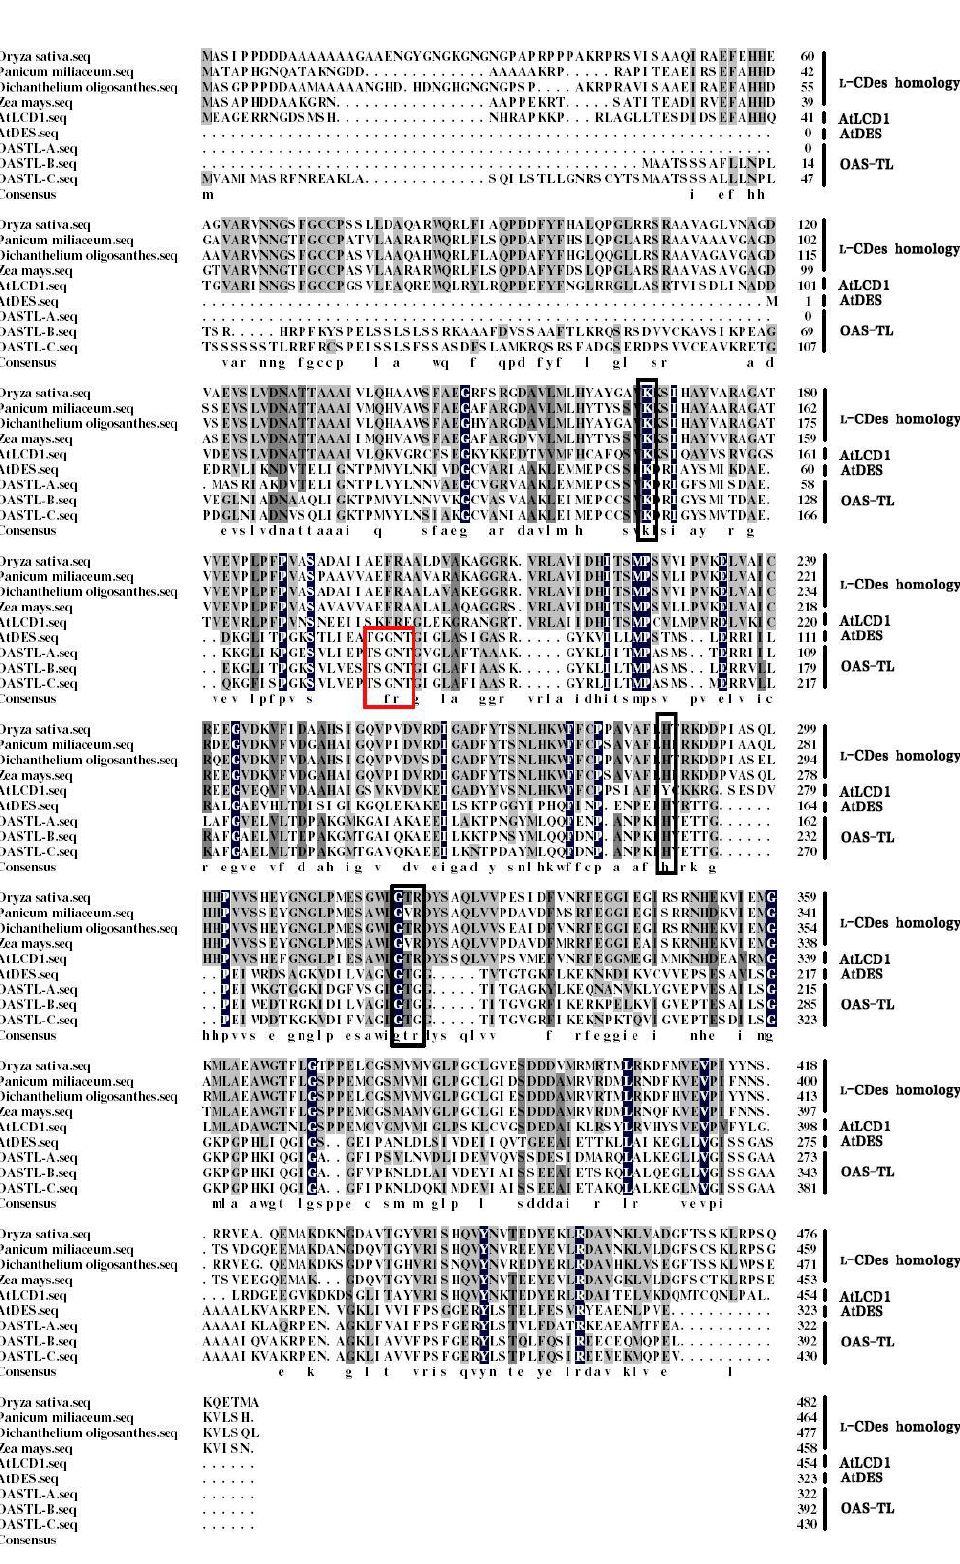
Figure 1. Sequence analysis of CDes, CDes homology, and OAS-TL-A, B, C proteins from the plant. The sequence alignment of L-CDes homology from Oryza sativa (XP_015613237), Panicum miliaceum (RLN24808), Dichanthelium oligosanthes (OEL32418), and Zea mays (PWZ10688) and AtLCD1 (NP_001327694), AtDES (OAO92103), OAS-TL-A (AEE83514), OAS- TL-B (AEC10318), and OAS-TL-C (AEE79963) from Arabidopsis thaliana was created by DNAMAN with default parameter. Amino acids with blue, black, and gray backgrounds indicate completely or highly conserved residues. The PLP binding sites are shown with a black box, the substrates binding sites of OAS-TL are shown with a red